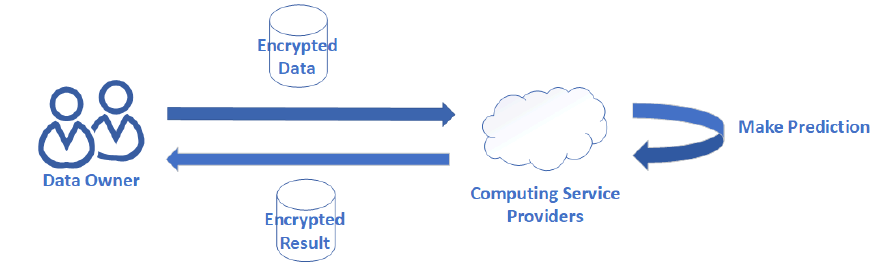
Figure 1. Privacy-preserving